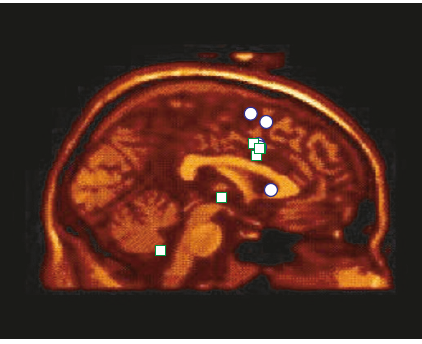
Figure 11: Localisation result for schizophrenic patients. The circles correspond to the P3a and the squares to P3b. The P3a and P3b are closely and irregularly located following no specific pattern.